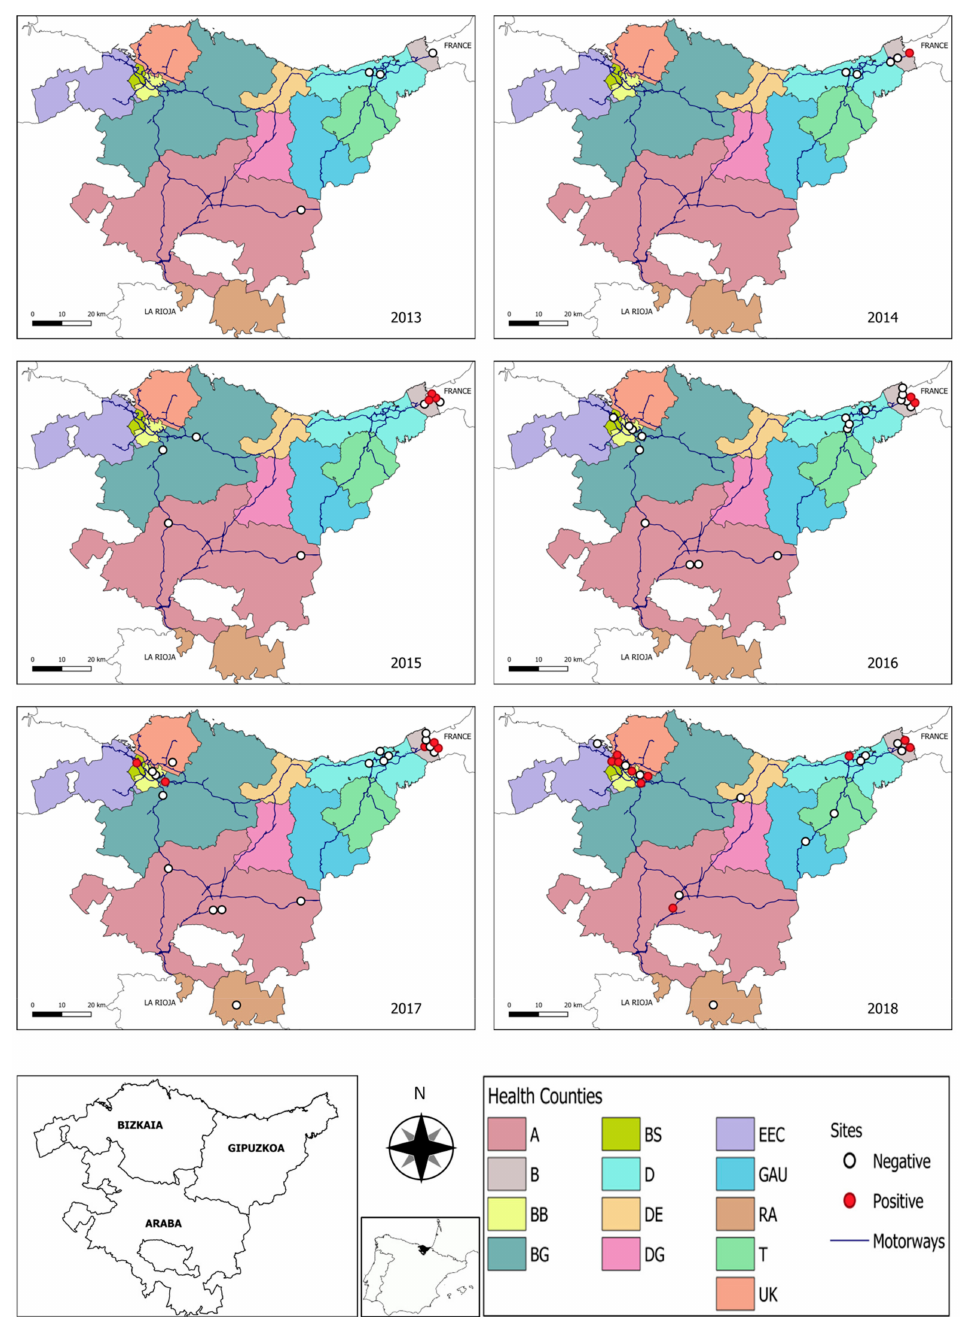
Figure 1. Maps of the Basque Country indicating the sites where ovitraps were placed in each year along the surveillance programme (2013–2018) (Source: Own elaboration based on GeoEuskadi data). Open circles denote negative sites, whereas presence of Ae. albopictus eggs in at least one ovitrap is indicated by red